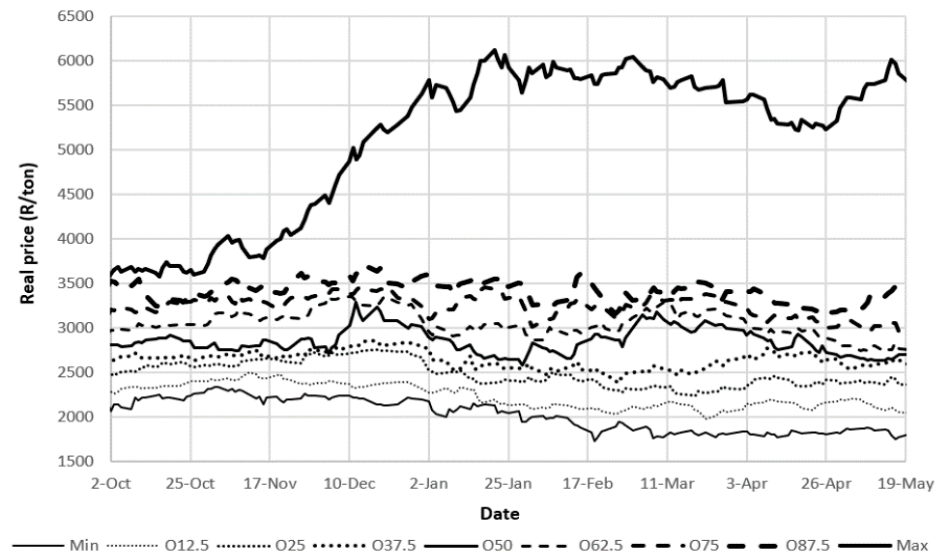
Figure 1. Octiles of the real prices for the May futures contract over the 11 marketing years (base year is 2020). Source: Data adapted from SAGIS data.